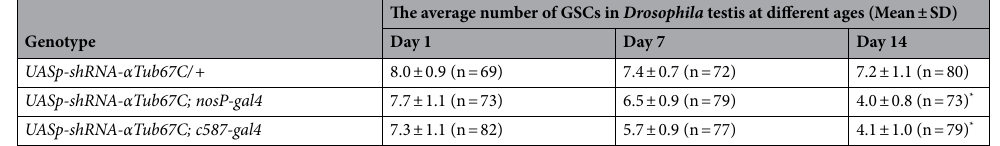
Table 2. Phenotypic assay for the αTub67C -specific knockdown in Drosophila testis. All the examined flies were cultured at 29 ℃ .SD, standard deviation. n, Number of testes examined. * P < 0.01, unpaired t -test, compared with parental control at day 14.